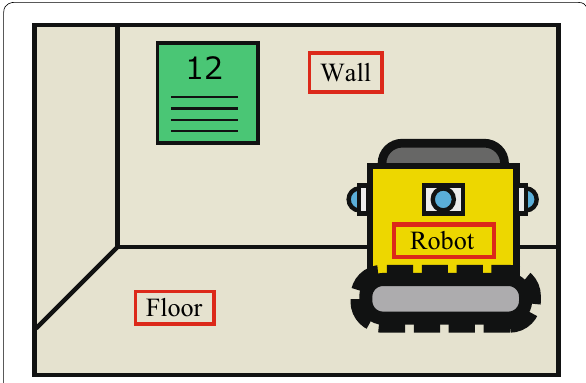
Fig. 2 Assumption of an indoor environment. It consists of three elements: robot, floor, and wall